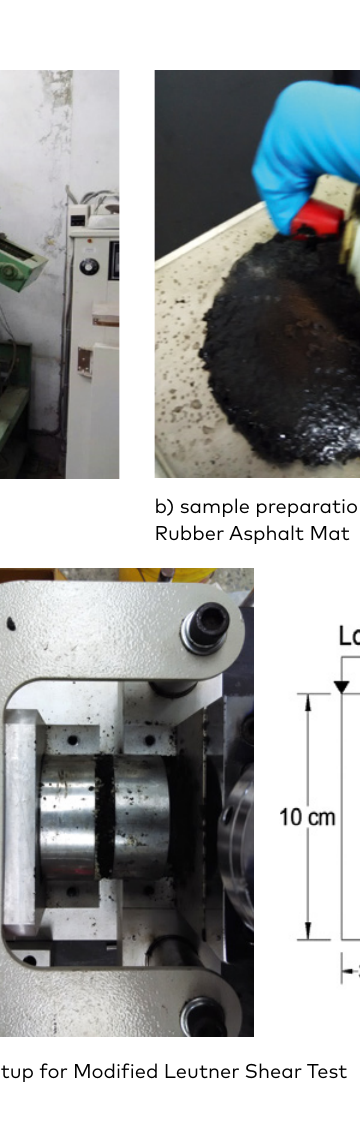
Figure 2. The sample preparation and test setup for the